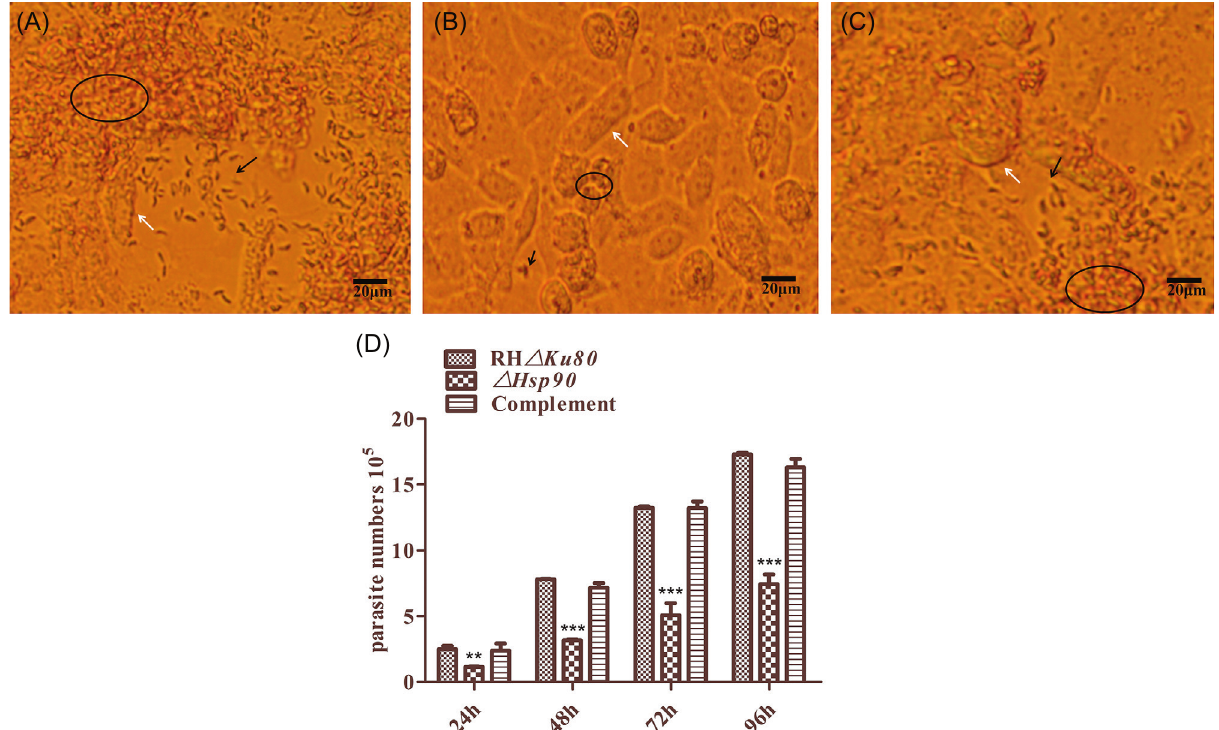
Figure 6. Growth of Hsp90 knockout parasite ( D Hsp90 ) in vitro. The parasites were cultured in African green monkey kidney (Vero) cells, 10 5 T. gondii were added to the 6-well plates, and the infection ratio was 1:1. Observation of RH D ku80 (A), D Hsp90 (B), and complemented (C) parasites by inverted microscope. The plaque produced by D PKAR strains (Fig. 6B) was significantly smaller than that of RH D ku80 and complemented parasites (Figs. 6A, 6C), scale bar = 20 l m. T. gondii tachyzoites and Vero cells were indicated by arrows, T. gondii (black arrow), Vero cells (white arrow). (D) The parasites were collected at the same time, and genomic DNA was extracted by TIANGEN kit. T. gondii DNA was detected by SYBR-green real-time PCR using B1 primer pairs, the standard curve was obtained by the known concentration of the RH D ku80 parasites with the primers (B1), and the parasite number was calculated by interpolation from this standard curve. ** p < 0.01, *** p < 0.001.